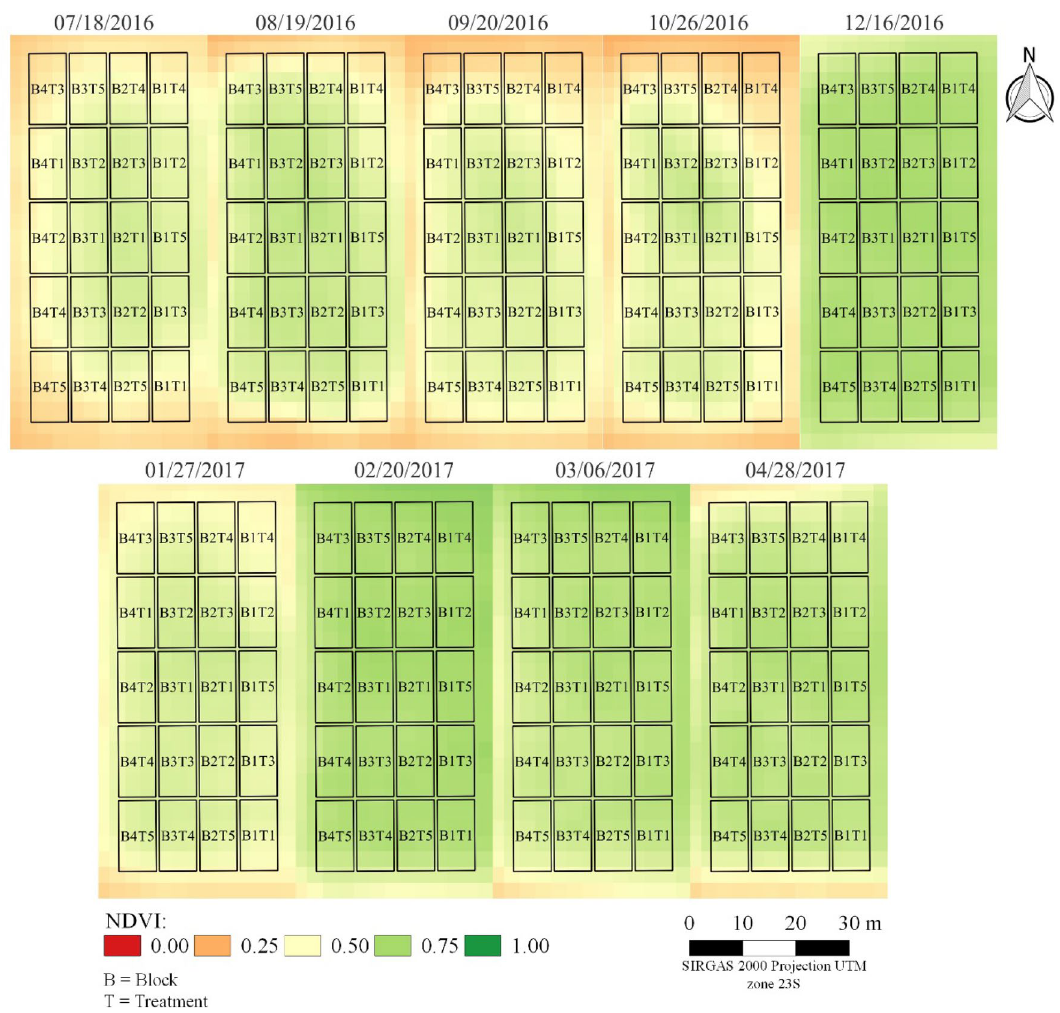
Figure 7. NDVI images from the PlanetScope constellation for the period of conduction of the experiment in Bom Jesus da Lapa, Bahia, Brazil.